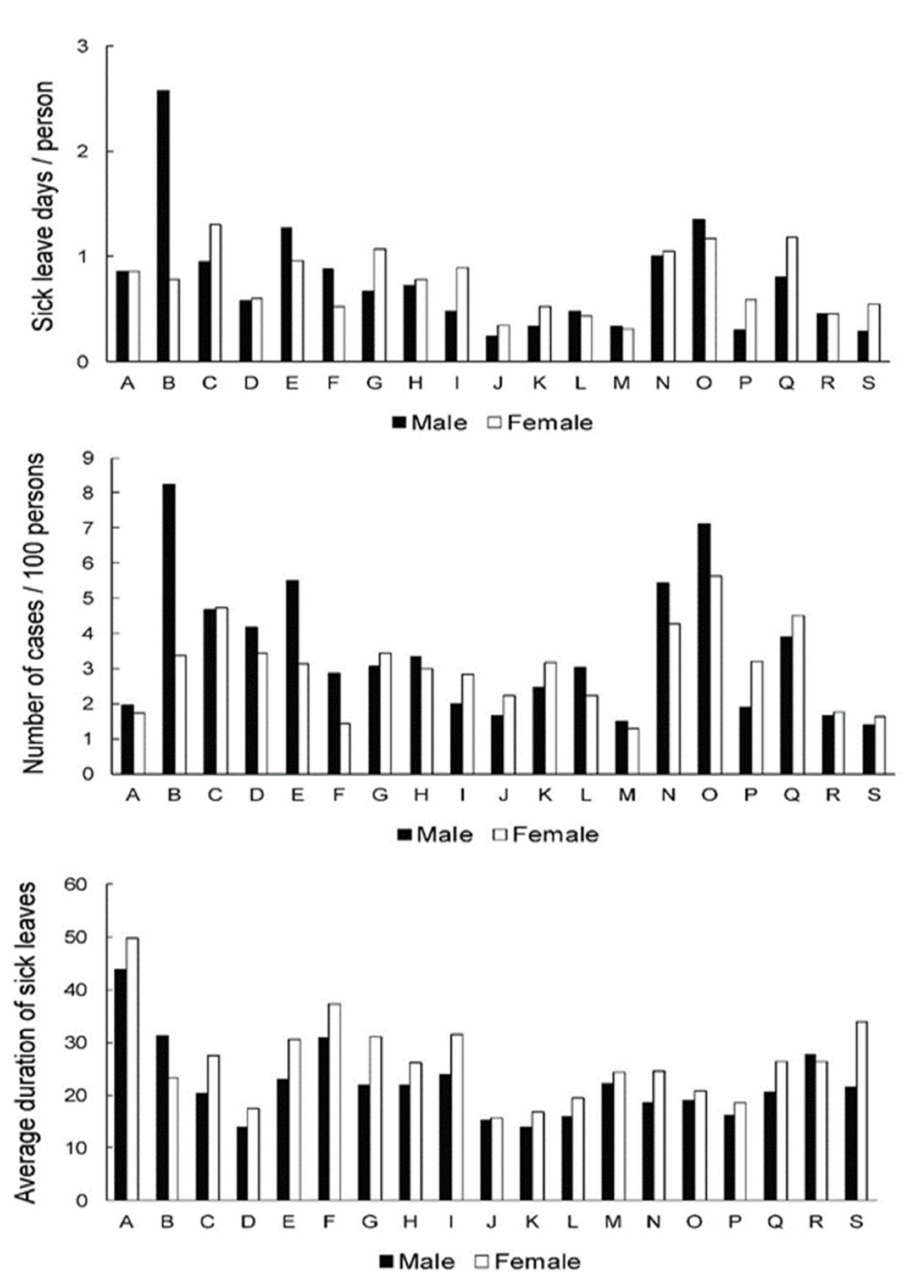
Figure 2. Sick leave days per person (index of temporary disability,) frequency of cases and severity (average case duration) of sick leave across genders and activities in 20.0–44.9-year-old group. A— agriculture, forestry and fishing; B—mining and quarrying; C—manufacturing; D —electricity, gas, steam, air cond. supply; E—water suppl; sewer., wst. manag., remed. act; F—construction; G— wholesale, retail; repair of mot. vehicles; H—transportation and storage; I—accommodation and food ser. activities; J—information and communication; K—financial and insurance activities; L—real estate activities; M—professional, scientific, technical act.; N—administrative and support service act; O—public admin, defense; compulsory soc. sec.; P—education; Q—human health and social work; activities; R—arts, entertainment and recreation; S—other service